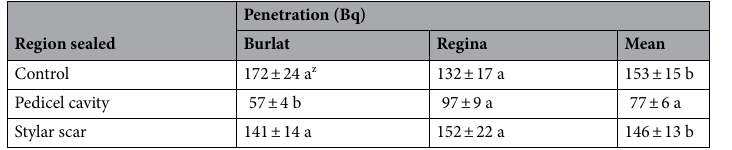
Table 1. Effects of selective sealing of potential sites of preferential uptake on penetration of 45 CaCl 2 into whole sweet cherry fruit. Fruit was incubated for 4 h in 50 mM CaCl 2 at a radioactivity concentration of 3.3 kBq ml −1 . The pedicel cavity or the stylar scar region were sealed with a fast-curing silicone rubber. z Mean separation within columns by Tukey’s Studentised range test at p ≤ 0.05.